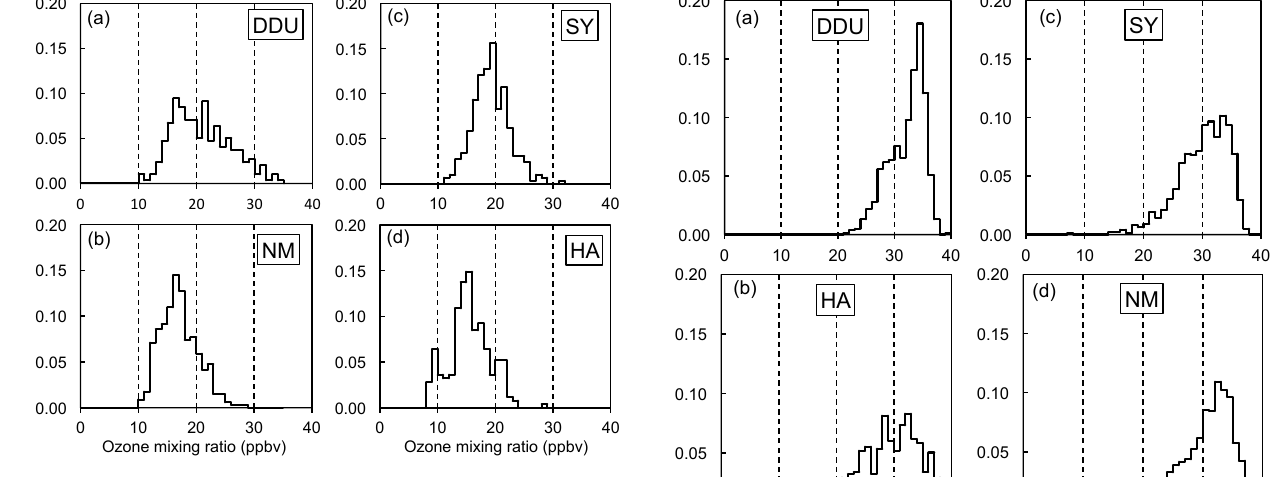
Figure 14. Frequency distribution of daily averaged O 3 mixing ra- tios observed in December (2004–2014) at the coastal sites of Du- mont d’Urville (a) , Neumayer (b) , Syowa (c) , and Halley (d) .